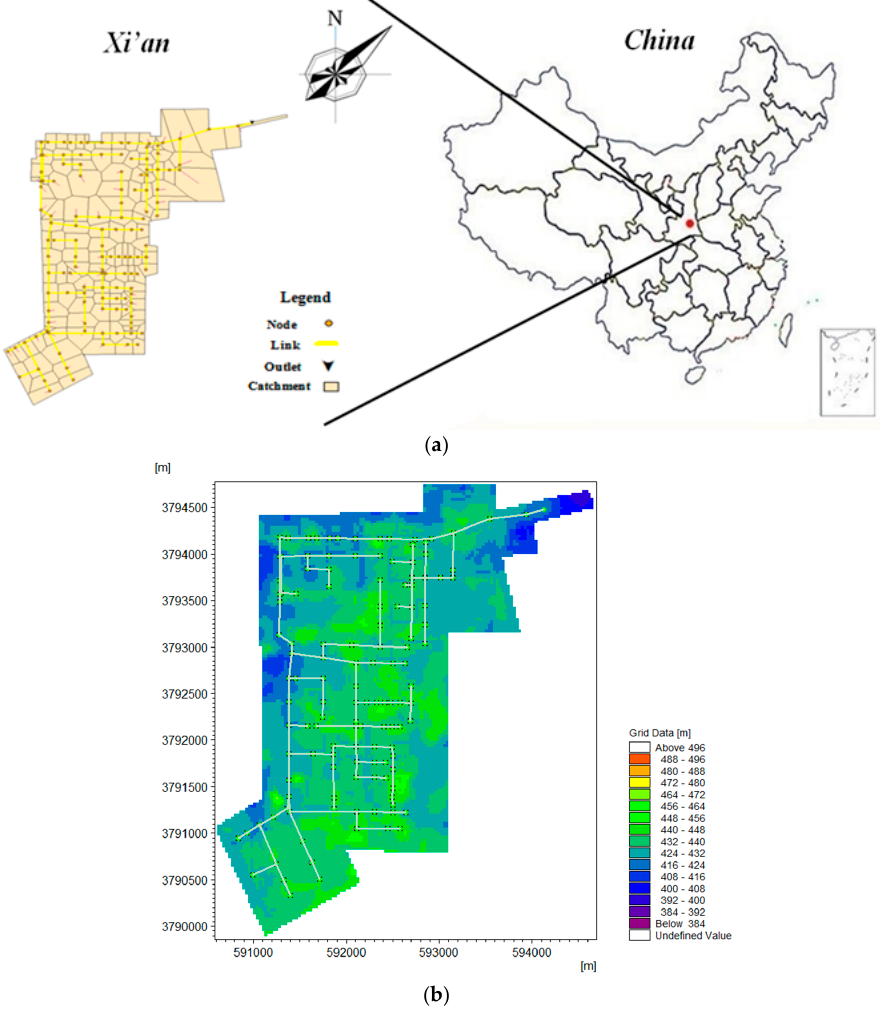
Figure 1. Models of 1D drainage ( a ) and 2D coupling ( b ).